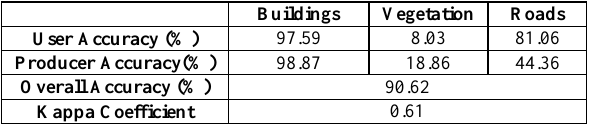
Table 1: Accuracy evaluation of the Torino test area.